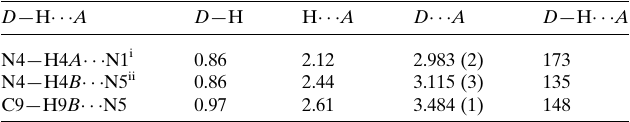
Table 1 Hydrogen-bond geometry (A˚ , (cid:2) ).